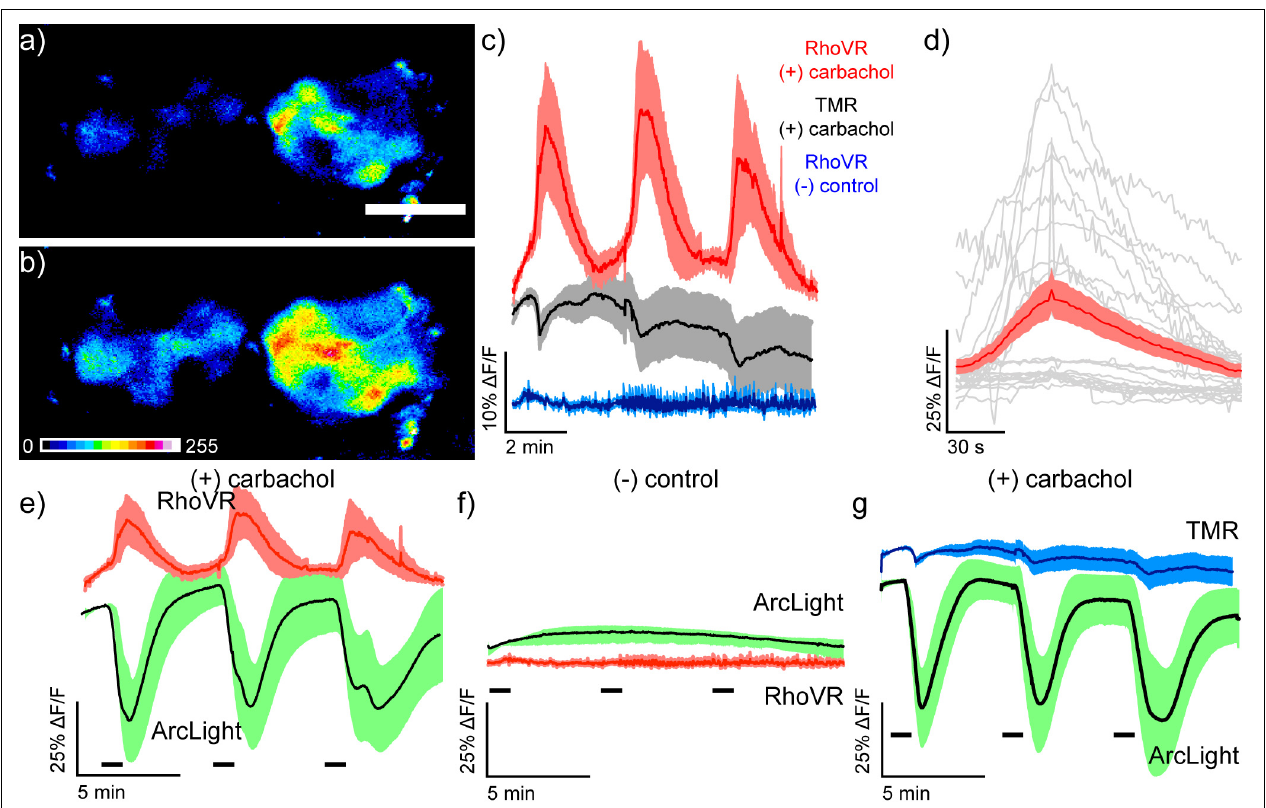
FIGURE 8 | Simultaneous two-color visualization of carbachol-induced depolarization in projection neurons of live Drosophila brain explants with RhoVR-Halo and ArcLight. Epifluorescence images of live explant Drosophila brain expressing HaloTag-CD4 in antennal lobe projection neurons (GH146-GAL4, UAS-HaloTag-CD4/CyO; UAS-ArcLight/TM2) and labeled with RhoVR-Halo (2 µ M) in live flies before dissection and explant imaging (a) immediately before and (b) 30 s after stimulation with 100 µ M carbachol. Scale bar is 50 µ m. (c) Plots of average (cid:49) F/F traces for Drosophila brains under the following conditions: stained with voltage-sensitive RhoVR-Halo (2 µ M) and stimulated with 100 µ M carbachol (red, n = 7 brains), stained with voltage-insensitive TMR-Halo (100 nM) and stimulated with 100 µ M carbachol (gray, n = 7 brains), or stained with voltage-sensitive RhoVR-Halo (2 µ M) and treated with vehicle control (blue, n = 6 brains). (d) Plots of individual (cid:49) F/F responses from RhoVR-Halo to carbachol stimuli (gray) and the average across all responses (red, SEM in light red). Traces of responses were aligned by peak response time and display 50 s before peak response and 150 s after peak response (gray). (e) Plots of average (cid:49) F/F traces for Drosophila brains stained with voltage-sensitive RhoVR-Halo (2 µ M) and stimulated with 100 µ M carbachol (red, n = 7 brains). ArcLight responses are recorded simultaneously (green, n = 7 brains). RhoVR traces are replicated from panel (c) for comparison with ArcLight. (f) Plots of average (cid:49) F/F traces for Drosophila brains stained with voltage-sensitive RhoVR-Halo (2 µ M) and then treated with a vehicle control (red, n = 6 brains). ArcLight responses are recorded simultaneously (green, n = 6 brains). RhoVR traces are replicated from panel (c) for comparison with ArcLight. (g) Plots of average (cid:49) F/F traces for Drosophila brains stained with voltage- insensitive TMR-Halo (100 nM) and stimulated with 100 µ M carbachol (blue, n = 6 brains). ArcLight responses are recorded simultaneously (green, n = 6 brains). TMR traces are replicated from panel (c) for comparison with ArcLight. For all plots, data are mean ± SEM for the indicated number of samples. Drosophila brain explants were stimulated three times for 30 s with either 100 µ M carbachol or vehicle. Stimulus (delivery of carbachol or vehicle) is depicted by small black bars immediately below the